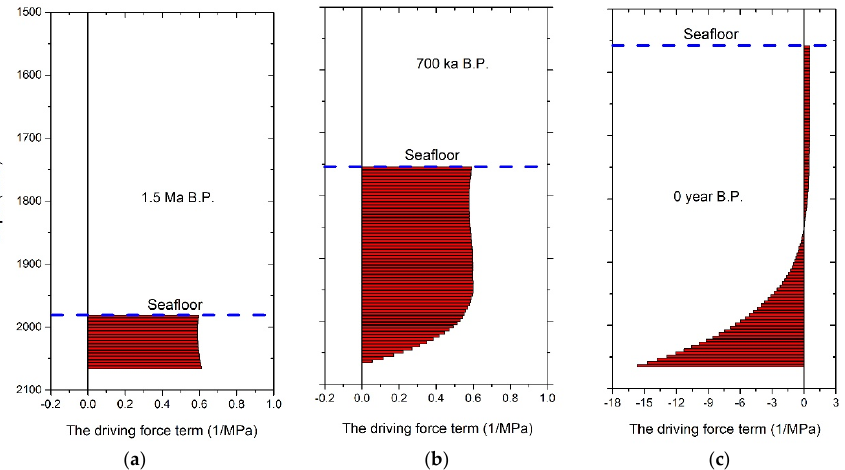
Figure 11. MH reaction term, r h / ζ 0 , appears at current slope location 1560 mbsl at the time points 1.5 Ma ( a ), 700 ka B.P. ( b ), and present ( c ), separately.